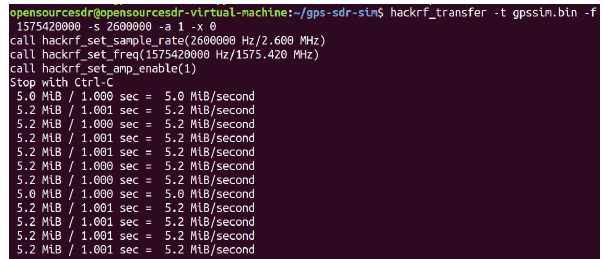
Figure 19. The fake GPS data transmission.